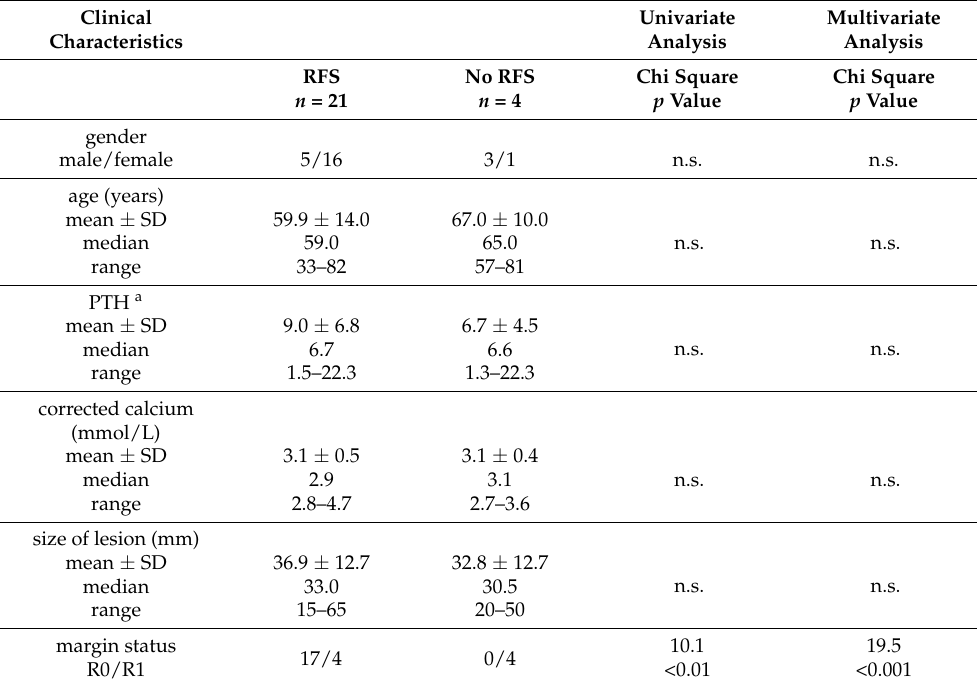
Table 2. Regression analysis for prediction of recurrence free survival